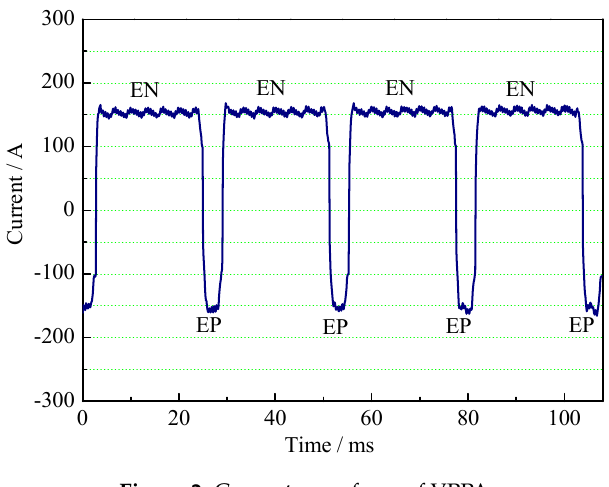
Figure 2. Current waveform of VPPA.